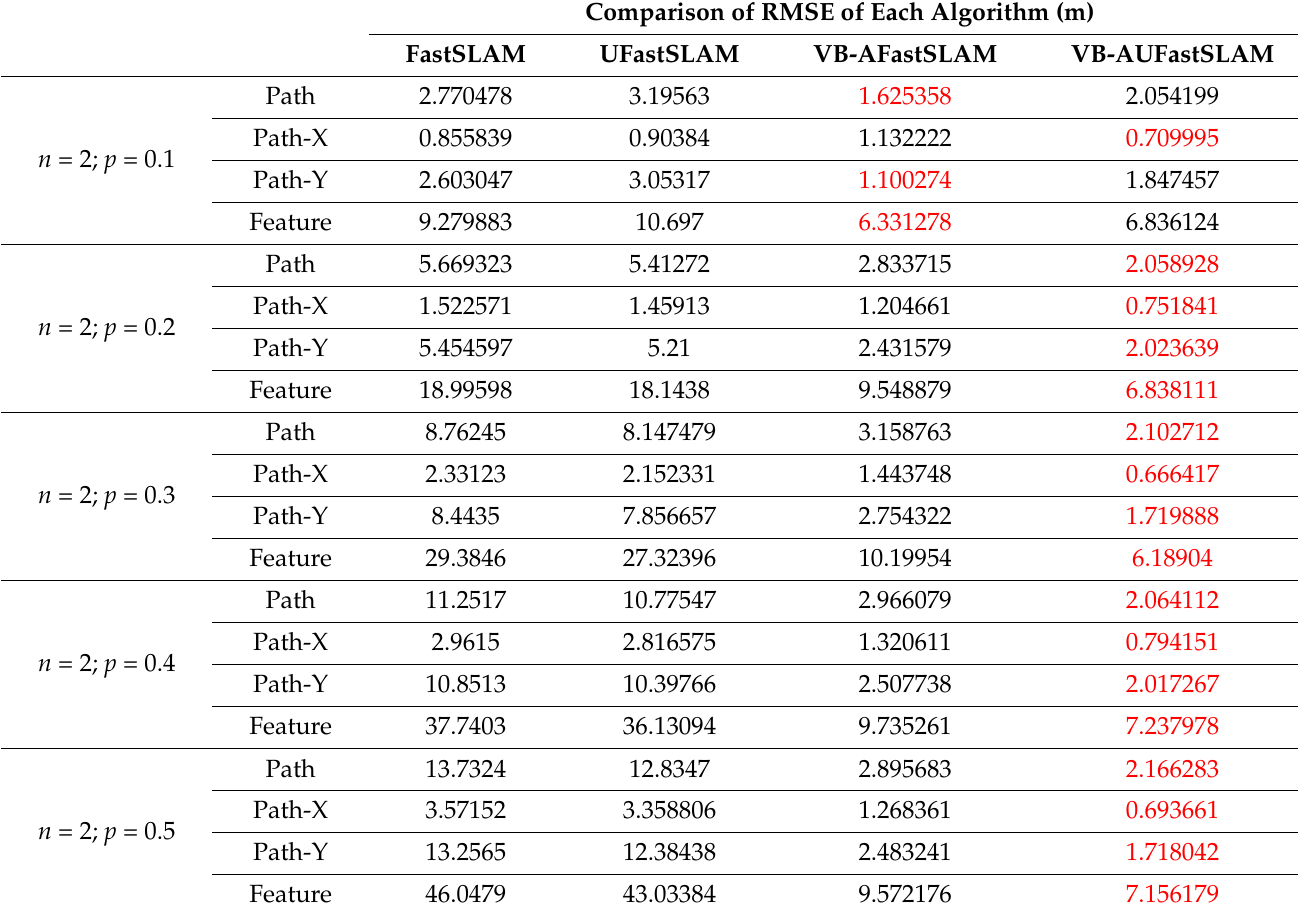
Table 4. n is constant, p